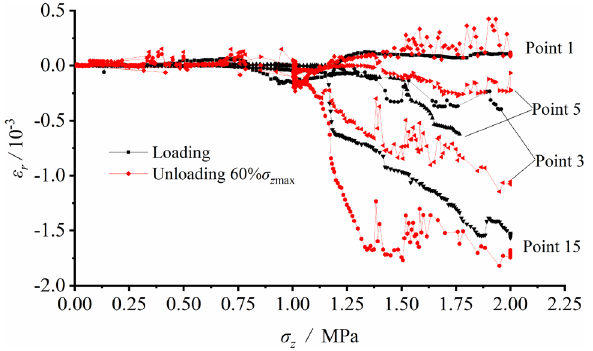
Figure 15. Tangential strain variation at each measuring spot around the tunnel in loading and unloading